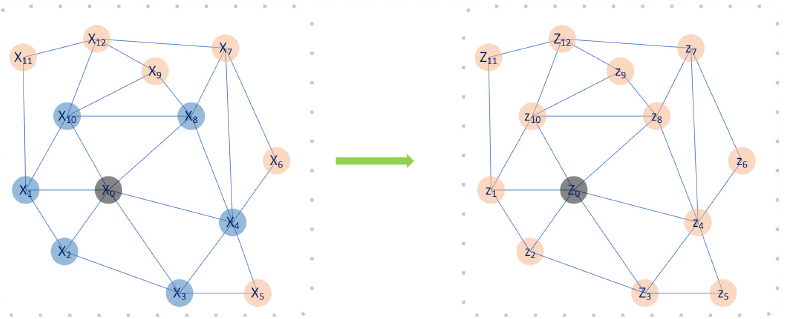
Figure 3. Example of a graph CNN’s function. For every node (coloured black in this instance), it takes the one-hop or two-hop neighbor as the receptive field. The blue nodes indicate the selected receptive field or neighbouring nodes, while the yellow ones are not selected for the black node. Graph CNNs use a filter to perform convolution on the selected nodes X i , resulting in the new status Z i , where the blue nodes are considered to calculate the black value in the right